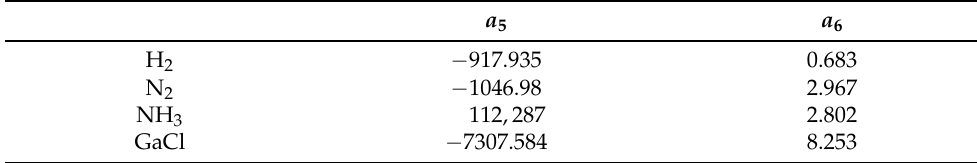
Table A4. Integration constants for C low p for each